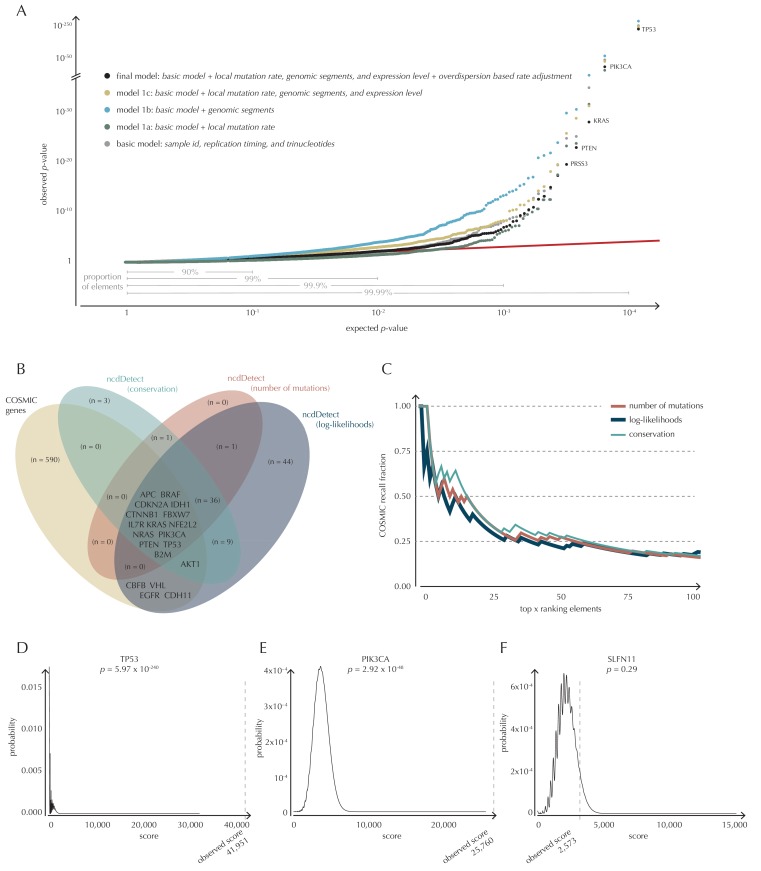
Analysis of protein-coding genes to evaluate ncdDetect performance.(A) The final null model is obtained through forward model-selection. The QQ-plot shows the p-values of all genes (n = 19,256) plotted against their uniform expectation under the null for each of the five models considered. Deviations from the expectations (red identity line) are seen for a varying proportion of the genes (0.5–10%). Results are shown for conservation scores. Similar plots for log-likelihoods and number of mutations are shown in Figure 4—figure supplement 1. (B) Venn diagram showing the overlap between protein-coding genes called as drivers by ncdDetect (q<0.10) for the three scoring schemes and the COSMIC Gene Census list. (C) COSMIC Gene Census recall plot. The fraction of COSMIC genes recalled in the top ncdDetect candidates. (D–F) The two most significant genes called by ncdDetect are TP53 and PIK3CA. An example of a gene not called significant is SLFN11. For each of these, the convoluted background score-distributions are shown together with the observed scores and resulting p-values.DOI:
http://dx.doi.org/10.7554/eLife.21778.01110.7554/eLife.21778.012Figure 4—source data 1.P-values obtained on protein-coding genes for each of the five models considered.The p-values are obtained using conservation scores. This data set relates to Figure 4A.DOI:
http://dx.doi.org/10.7554/eLife.21778.01210.7554/eLife.21778.013Figure 4—source data 2.COSMIC Gene Census recall data.The fraction of recalled COSMIC genes in the top ncdDetect candidates, for the three different scoring schemes. This data set relates to Figure 4C.DOI:
http://dx.doi.org/10.7554/eLife.21778.01310.7554/eLife.21778.014Figure 4—source data 3.The background score distribution for the protein-coding gene TP53 obtained with conservation scores.This data set relates to Figure 4D.DOI:
http://dx.doi.org/10.7554/eLife.21778.01410.7554/eLife.21778.015Figure 4—source data 4.The background score distribution for the protein-coding gene PIK3CA obtained with conservation scores.This data set relates to Figure 4E.DOI:
http://dx.doi.org/10.7554/eLife.21778.01510.7554/eLife.21778.016Figure 4—source data 5.The background score distribution for the protein-coding gene SLFN11 obtained with conservation scores.This data set relates to Figure 4F.